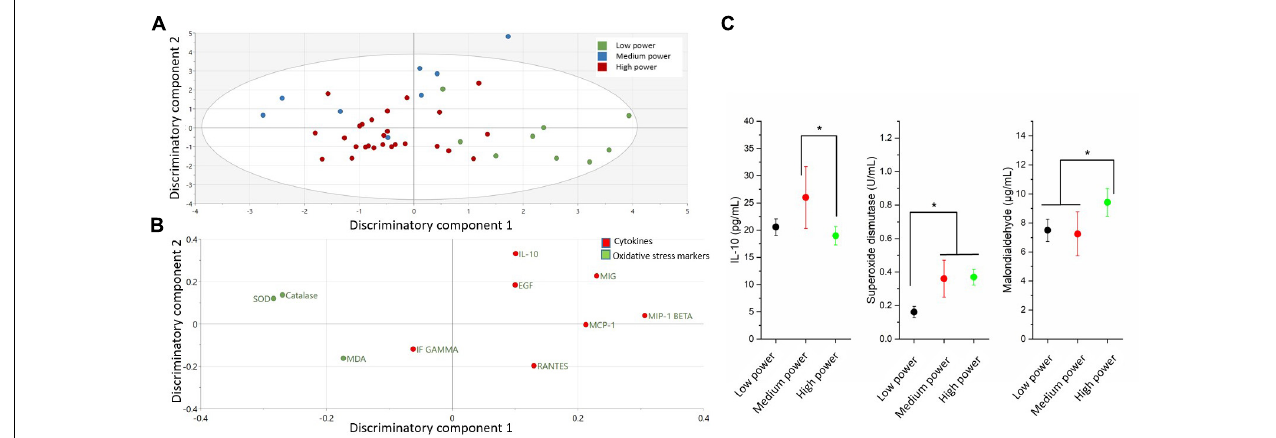
FIGURE 1 | Differences in cytokines and oxidative stress markers among power groups (low, moderate and high). (A) The score plot of OPLS-DA model comparing analytes from three power groups exhibits class-discriminatory component 1 ( x -axis) versus class-discriminatory component 2 ( y -axis). (B) The corresponding loading plots shows top associated analytes differentiating low, moderate and high power groups. (C) Significant differences in cytokines and oxidative stress markers among the three power groups by KS test (* p < 0.05).